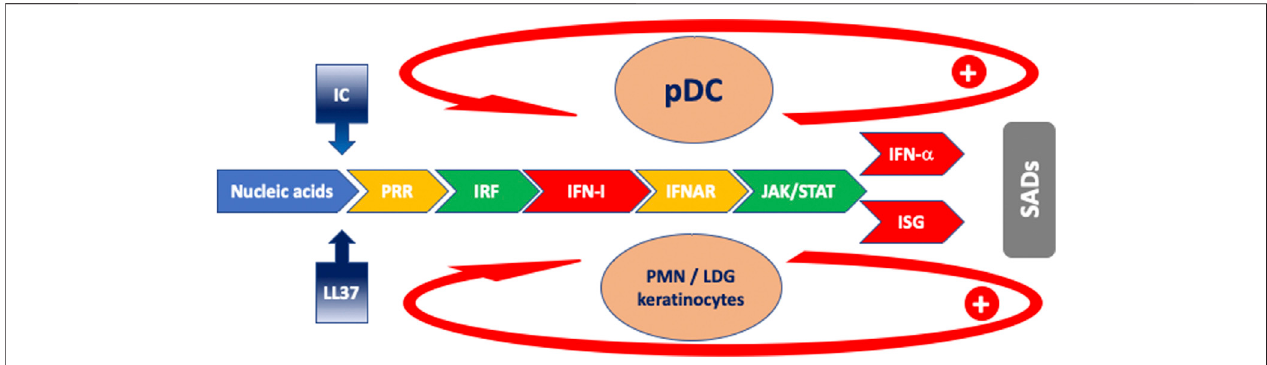
FIGURE 1 | Schematic model of the cascade of events characterizing the IFN response in SADs. Blue: antigen drive; gradient blue: facilitator mechanisms for antigen uptake; yellow: receptors; green: intracellular signaling; red: IFN and ISG. The arrows indicate feed-forward regulatory mechanisms. Orange ovals: main cells implicated in IFN-I production. Abbreviations: IC: immune complexes; IFNAR: interferon-alpha/beta receptor; ISG: interferon-stimulated gene; ISRE: IRF: interferon regulatoryfactor;JAK:Januskinase;LDG:low-densitygranulocyte;LL-37:cathelicidin-37;pDC:plasmacytoiddendriticcell;PMN:polymorphonuclearneutrophil; PRR: pattern recognition receptor; SADs: systemic autoimmune diseases; STAT: signal transducer and activator of transcription.